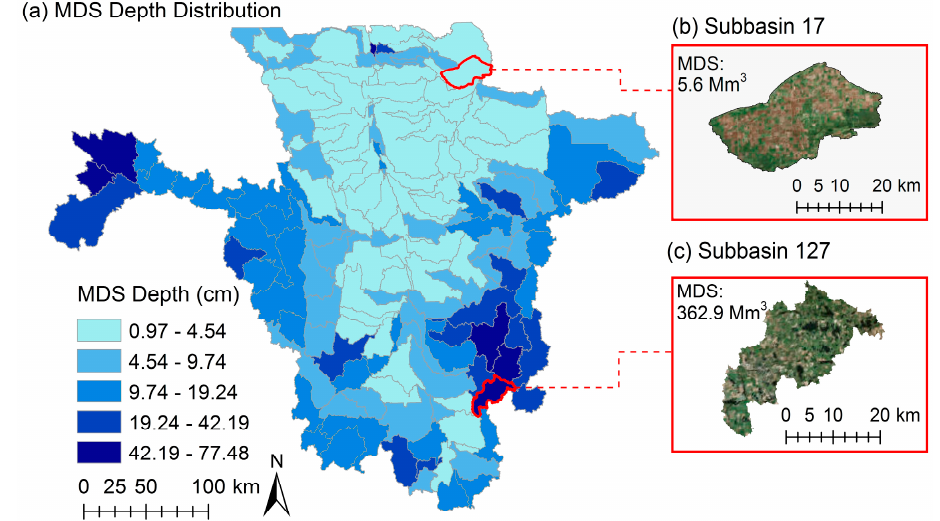
Figure 3. ( a ) Distribution of maximum depression storage (MDS) depths over the study area and two selected subbasins with ( b ) minimum MDS, and ( c ) maximum